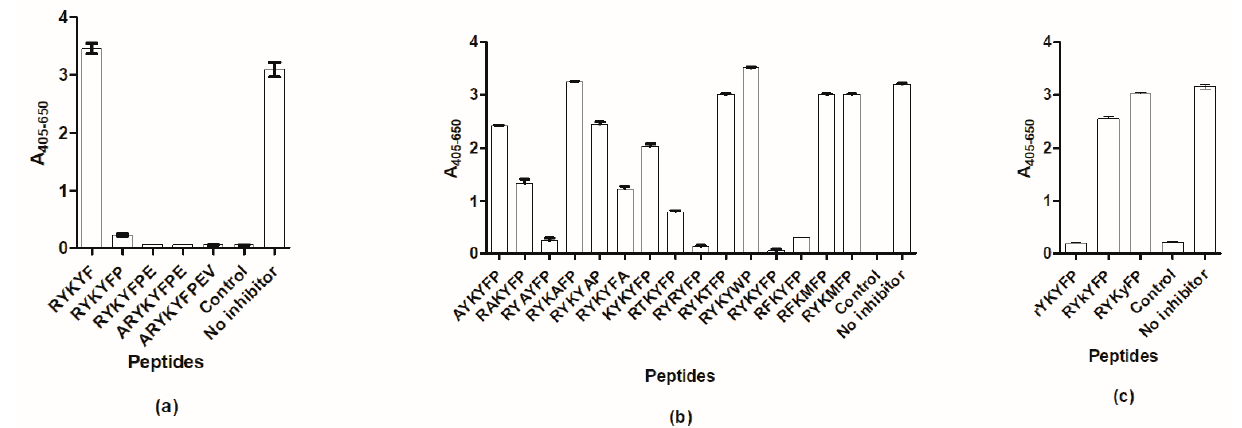
Figure 5. Epitope identification of SSI-HYB 387-01 analyzed by competitive inhibition assays. ( a ) Antibody reactivity to epitope variants. ( b ) Antibody reactivity to Ala- and functionality-substituted peptides. ( c ) Antibody reactivity to D-amino acid-substituted peptides. Glutamic acid decarboxylase (GAD)67 full-length peptide was used as a positive control.